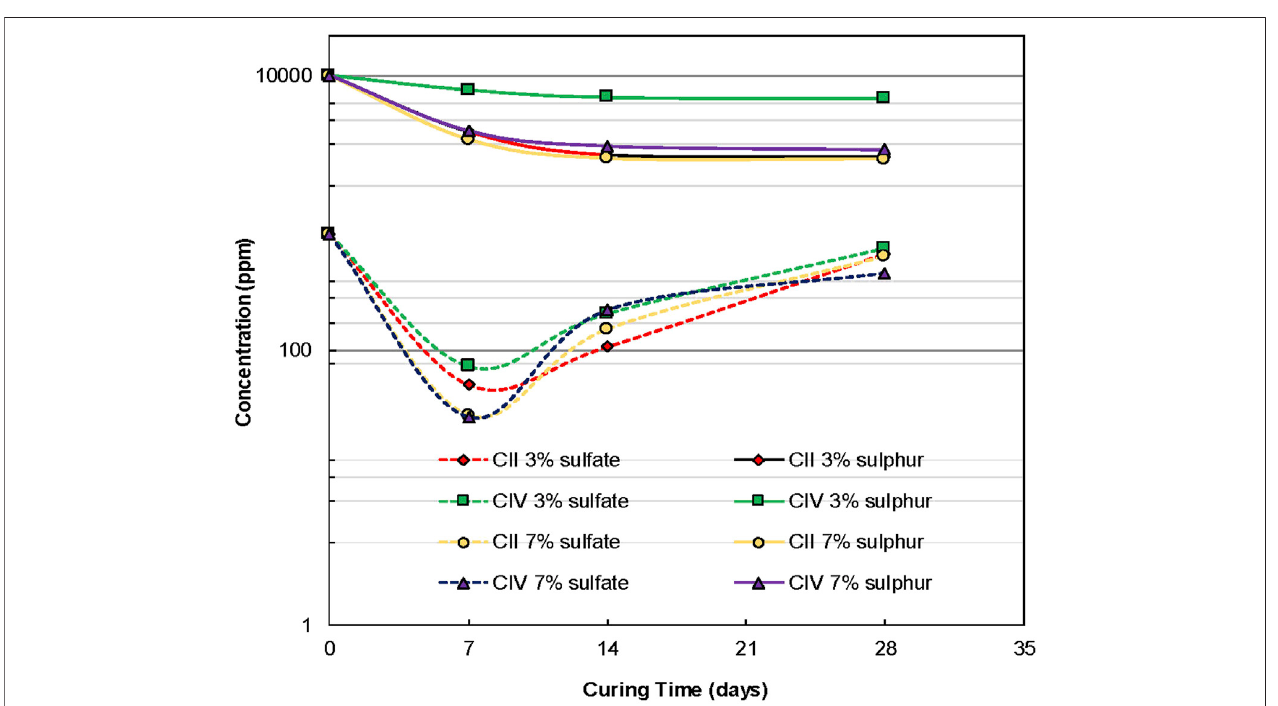
FIGURE 8 | Time-dependent sulfate (by ion analysis) and sulfur (by combustion)